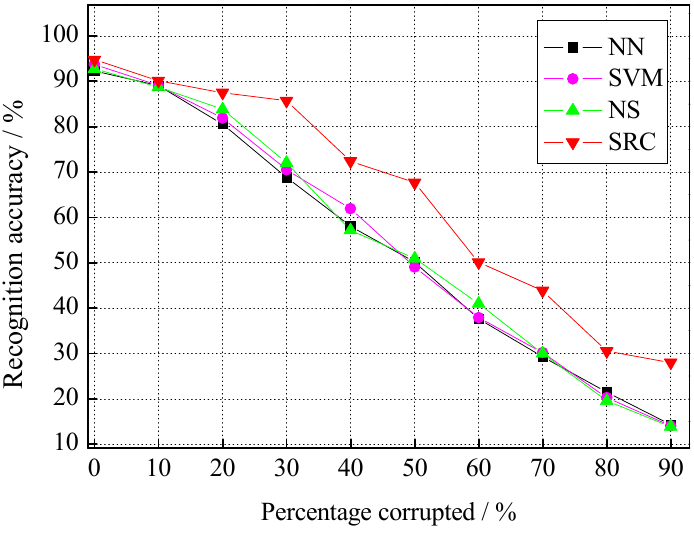
Figure 6. Recognition accuracy under different percentage